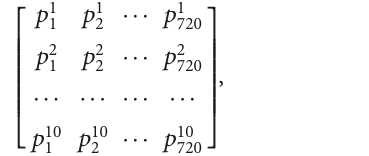
Figure 8: The MMS-PE results of standard data: (a) m α Z (cid:31)